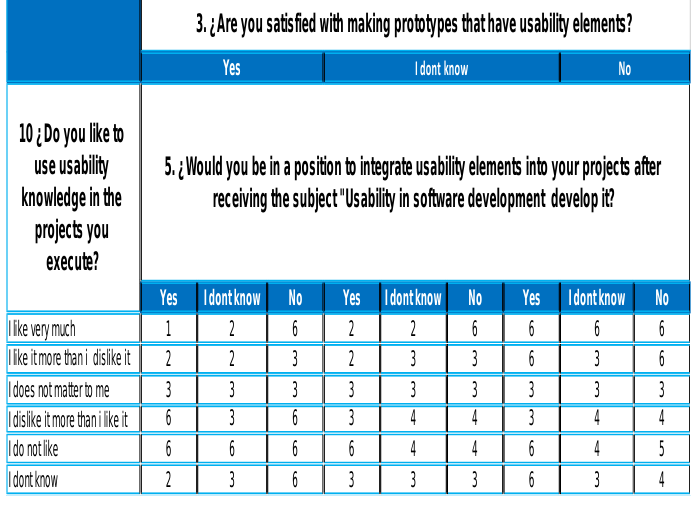
Fig. 8. Logical chart of Iadov